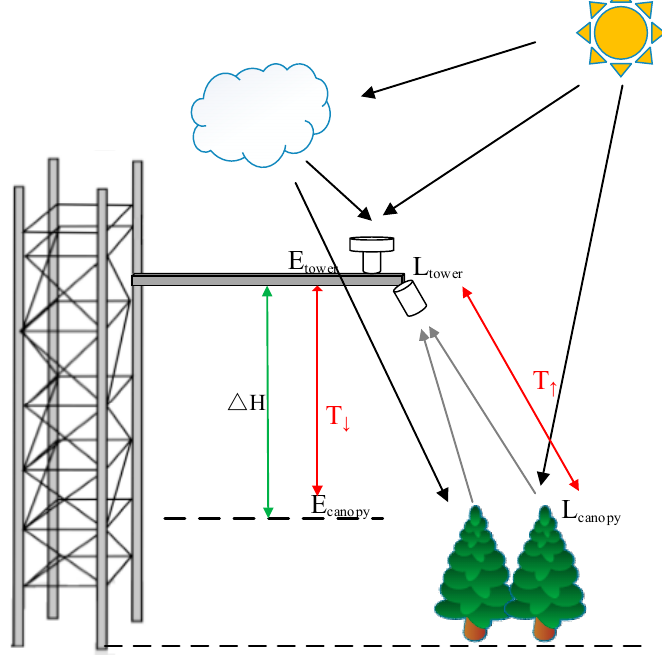
Figure 5. Schematic diagram of the atmospheric correction for tower-based SIFSpec system observations. E tower and E canopy are the downward irradiance at the sensor and top of the canopy; L tower and L canopy are the upward radiance arriving the sensor and at the top of the canopy; ∆ H is the height between the canopy and the sensor; T ↑ and T ↓ are the upward and downward atmosphere transmittances between the canopy and the sensor, respectively.